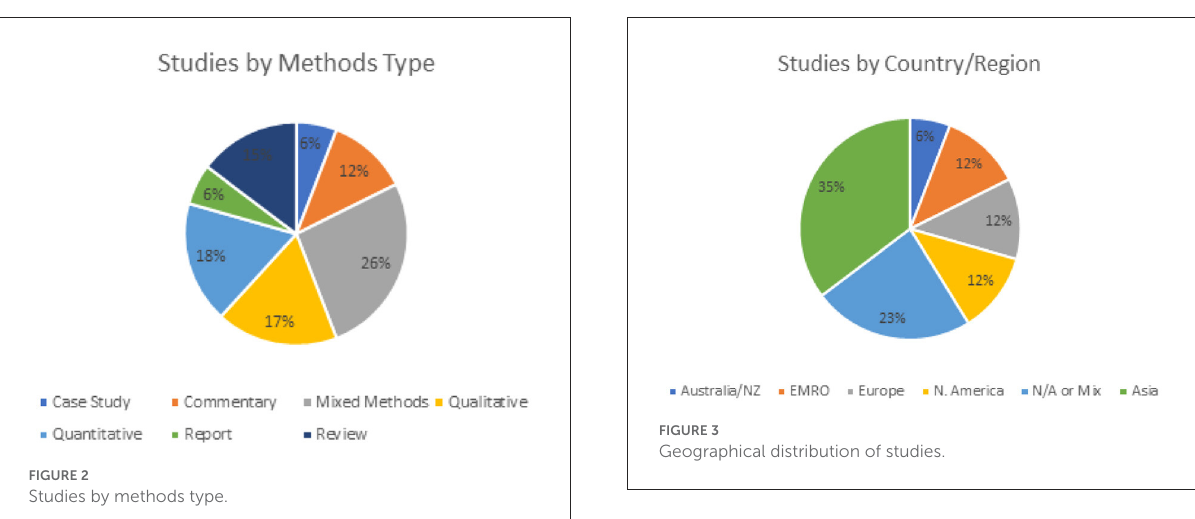
4. Chart the data : Included entries was extracted on Microsoft